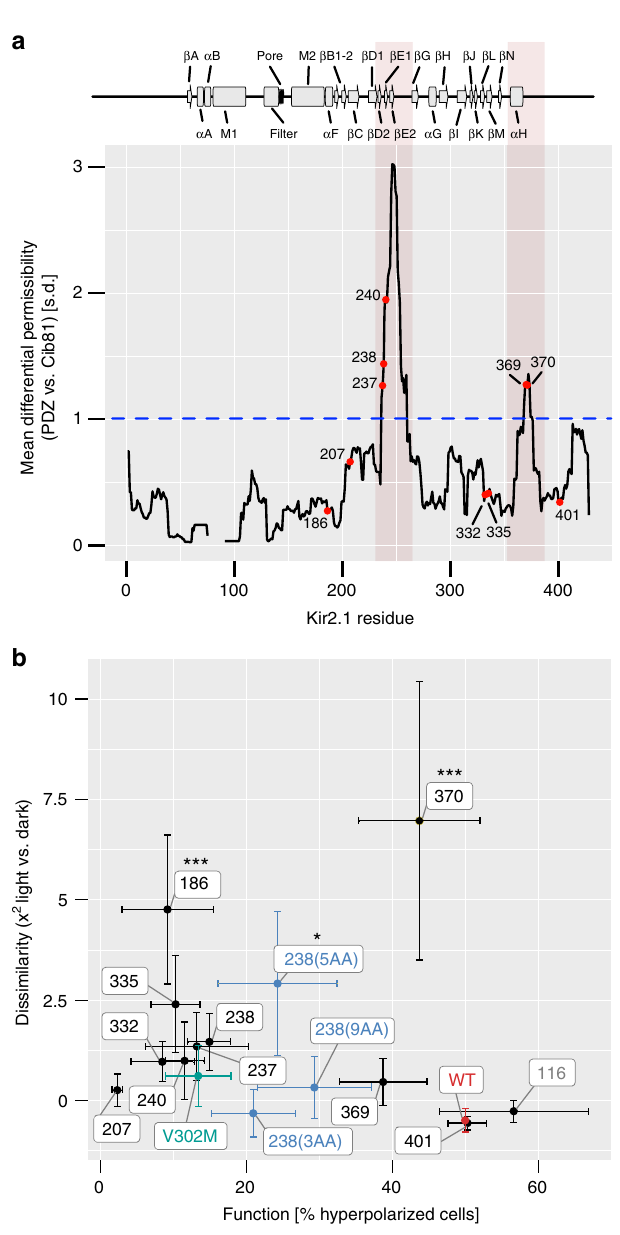
Fig. 6 Light-modulated Kir2.1 variants. a Moving average (window size: 15 residues) of permissibility z-score difference between PDZ and Cib81 datasets. Regions in which differential permissibility exceeds one standard deviation (dashed blue line) are shaded in red. Individual residues subjected to the light-switching assay are shown as labeled red dots. b Dissimilarity ( Χ 2 ) of K + -induced depolarization with and without illumination (Supplementary Fig. 11) plotted against insertion variant function (Fig. 5). Mutants are highlighted after linker optimization (blue), gating mutant V302M (green), and wild-type Kir2.1 (red). Signi fi cance of light modulation is tested by Dunnett ’ s test for multiple comparisons with wild-type as control and post hoc multiple comparison adjustment. Error bars are standard deviations on the x-axis (each insertion variant n = 3 – 5, and wild- type n = 21) and s.e.m. on the y -axis ( n = 3). Signi fi cance levels: *** P < 0.001; ** P < 0.01; * P < 0.05, all others not signi fi